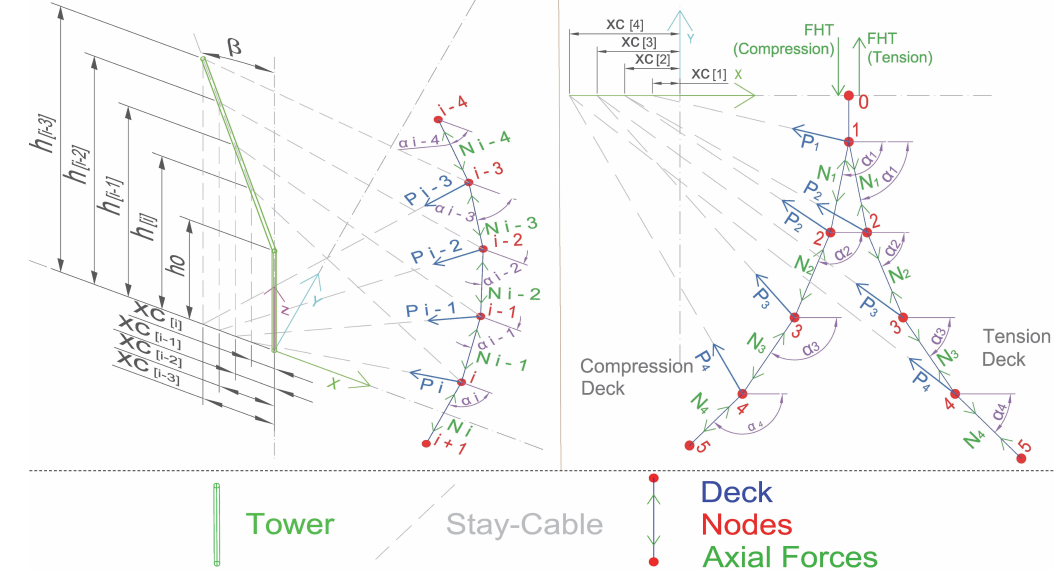
Figure 1: Discrete calculation of directrix, boundary conditions. Funicular and anti-funicular.